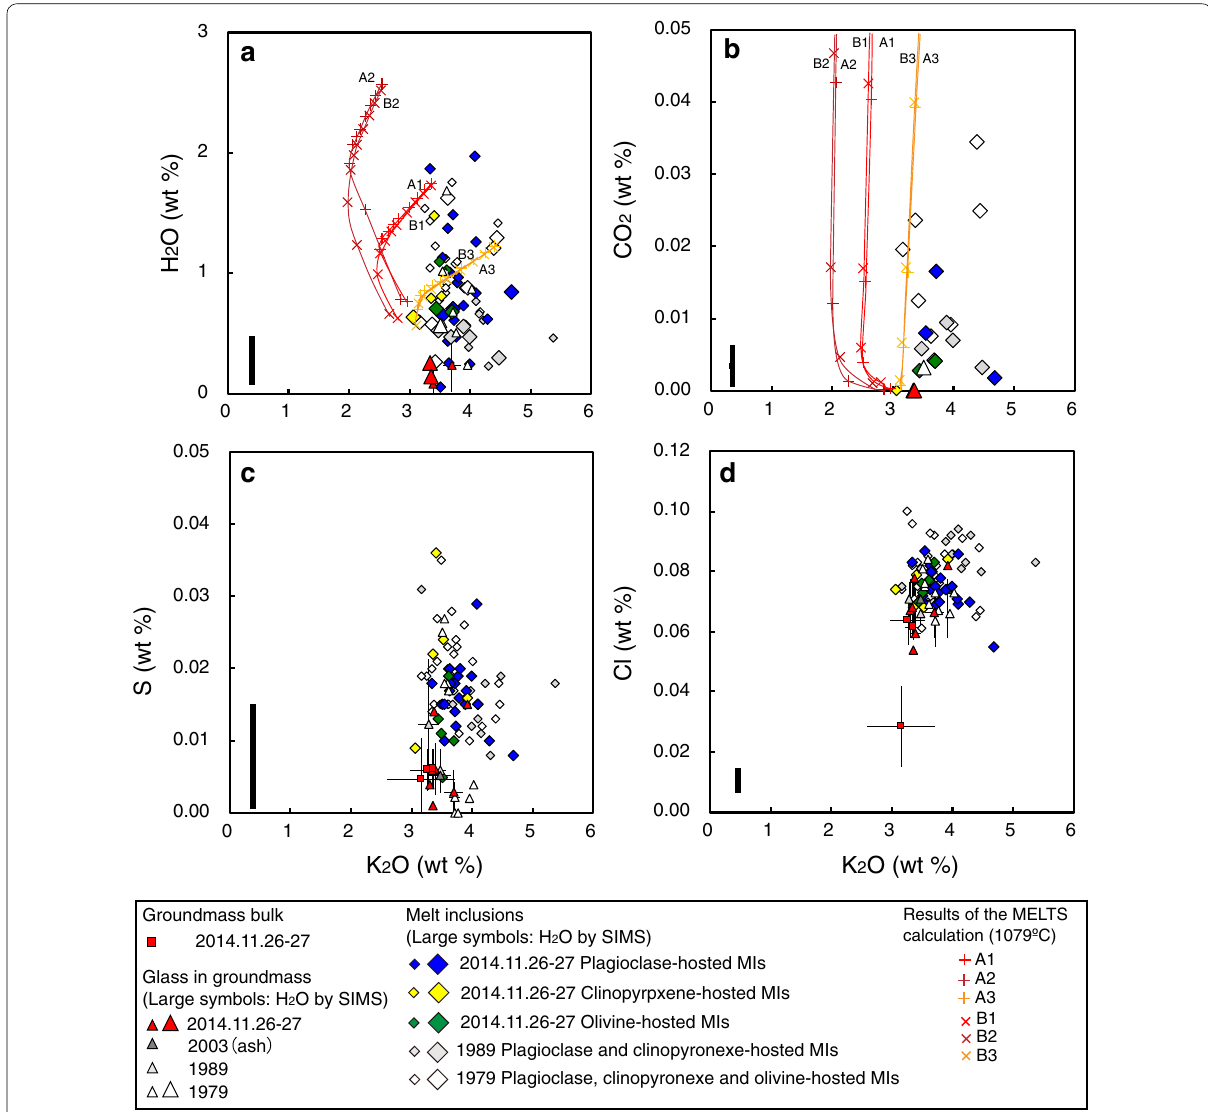
Fig. 5 Volatile and K 2 O contents of the melt inclusions and groundmass in the scoria. a H 2 O and K 2 O contents, b CO 2 and K 2 O contents, c S and K 2 O contents, and d Cl and K 2 O contents of the melt inclusions and groundmass. The large symbols indicate H 2 O and CO 2 contents measured by SIMS. Error bars indicate the analytical errors of H 2 O and CO 2 by SIMS and those of S, Cl, and K 2 O by EPMA. The EPMA analytical error of H 2 O is Chemical compositions of the melt calculated from the whole-rock composition of I141129S01 at 1079 °C using the MELTS program (Table 5; Additional file 3: Table S2) are also shown. Curves with cross symbols show the compositional change associated with a decrease in pressure from 600 to 10